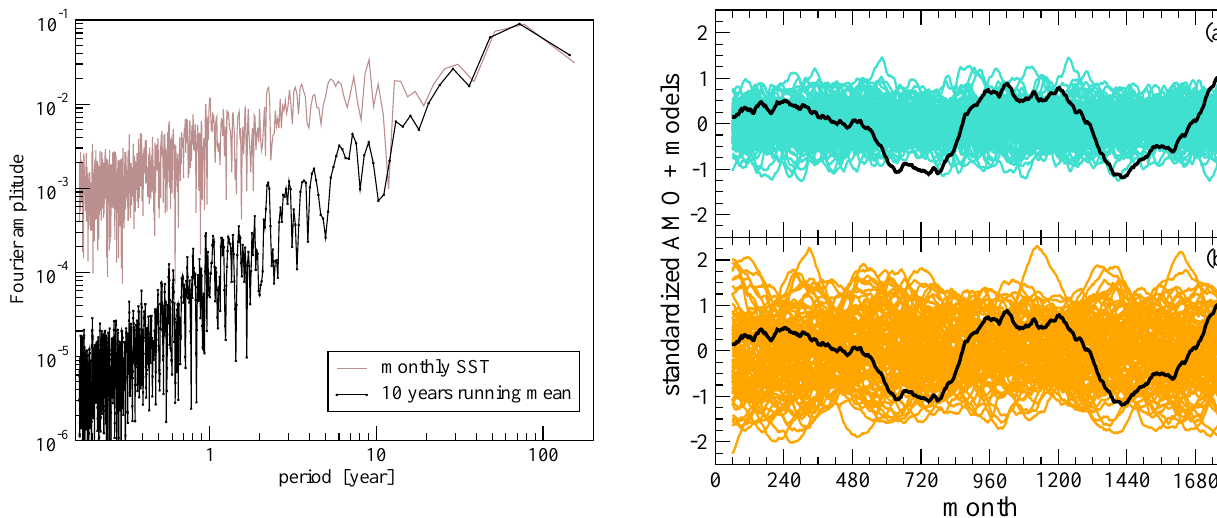
Fig. 6. Power spectra of the original monthly SST series (brown) and its 121 month running average, the AMO index (black with symbols), as a function of period length.